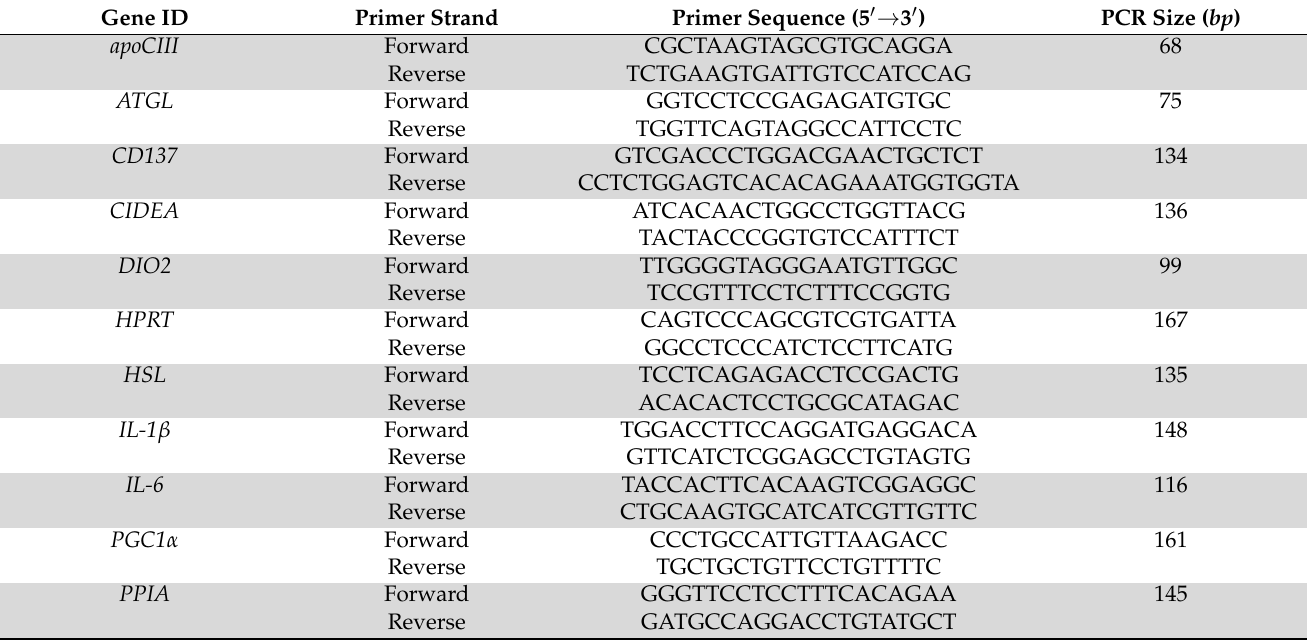
Table 1. Primers used for gene expression by qRT-PCR. Sequences of each primer pair (forward and reverse) from 5 (cid:48) to 3 (cid:48)